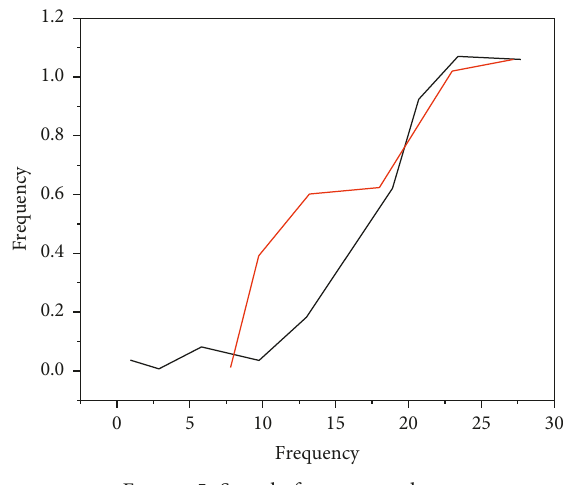
Figure 5: Sample frequency